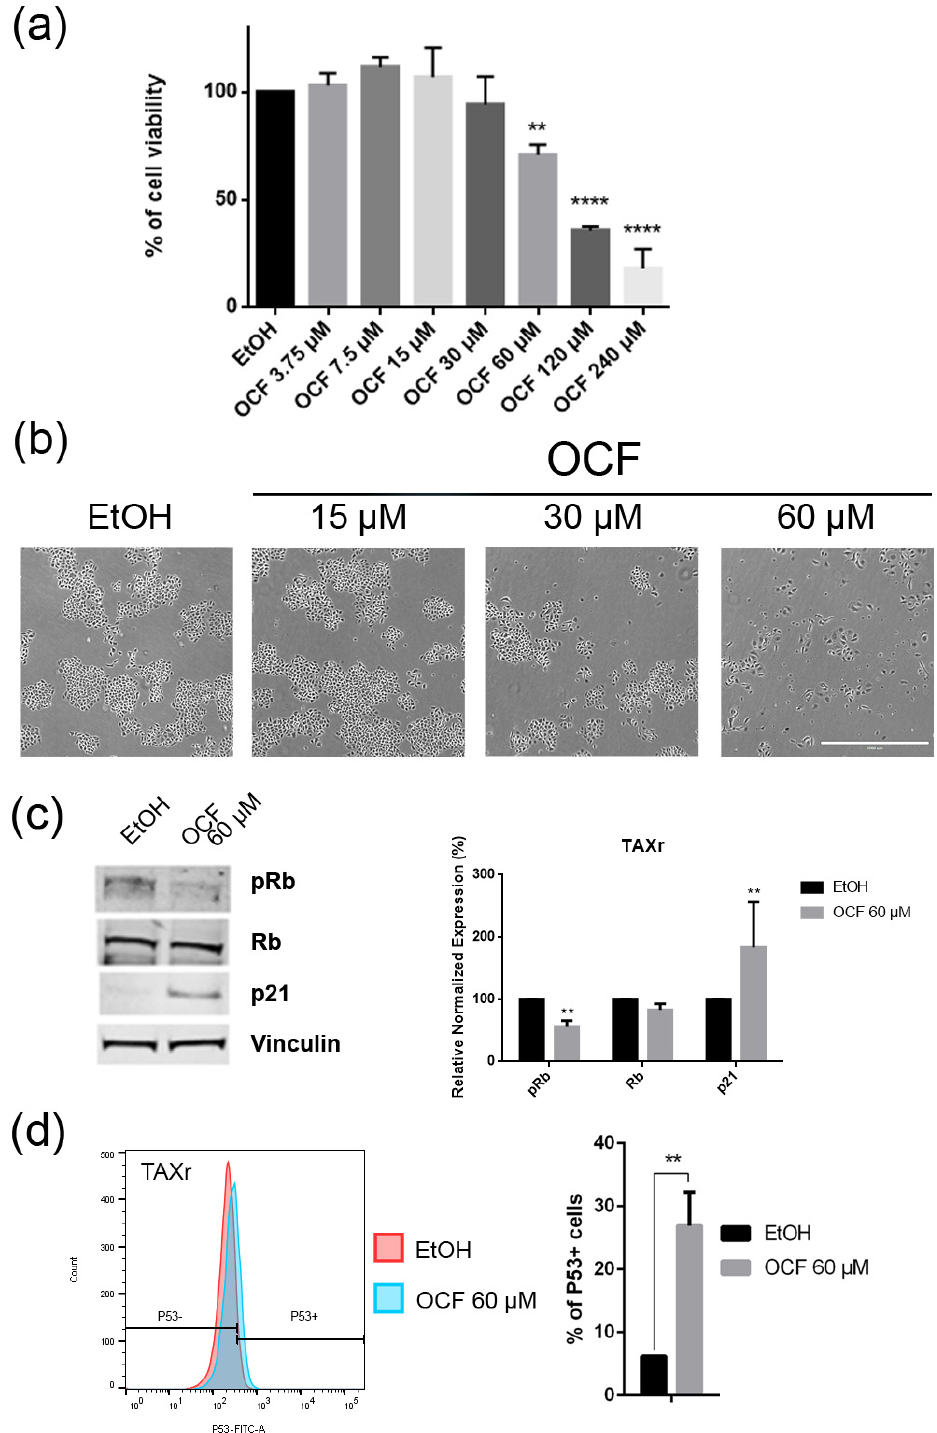
Figure 6. Effects of the different doses of the OCF on TAXr cells. TAXr cells, treated for 72 h with vehicle or with different doses of the OCF, were analyzed through a MTT assay ( a ); pictures were obtained with an inverted microscope at 4x magnification ( b ); representative western blot analysis of p-Rb, Rb, p21 and vinculin levels in the TAXr cells treated with vehicle or 60 µM dose of the OCF for 24 h and the corresponding densitometry ( c ). Flow cytometry plots for the p53 staining and the corresponding histograms ( d ). Data are presented as mean ± SD of three independent experiments. Results of the representative experiments are shown. ** p < 0.01, **** p < 0.0001. ( a ) One-way ANOVA Dunnett’s multiple comparisons test; ( c , d ) Two-way ANOVA Sidak’s multiple comparisons